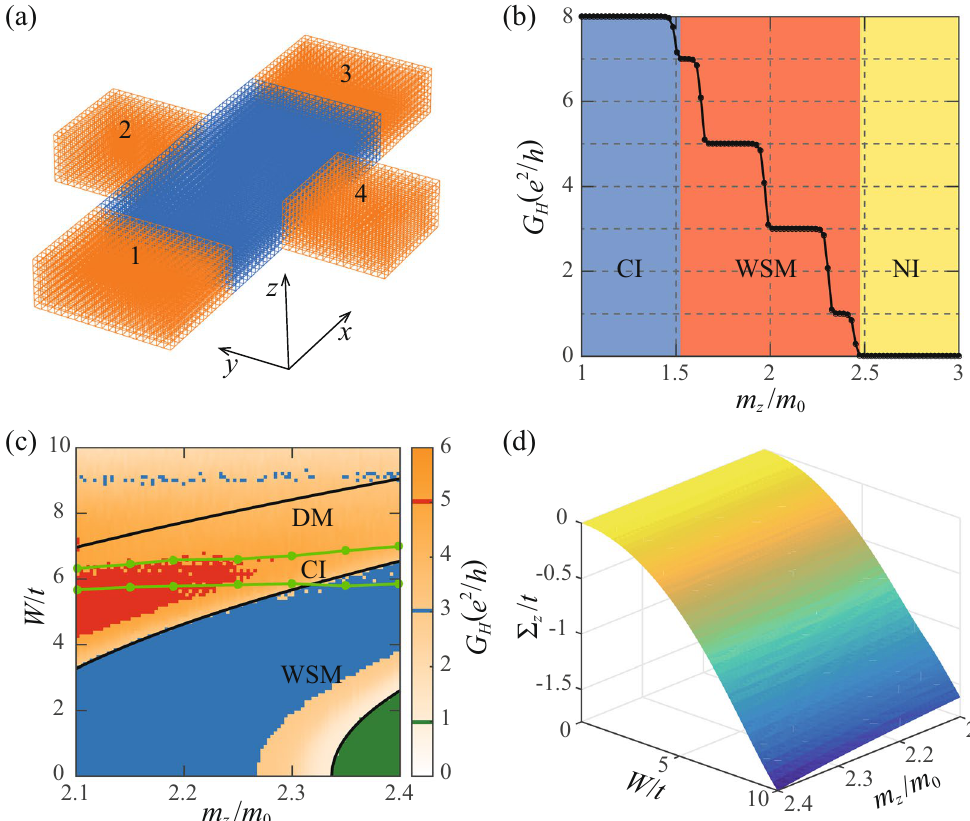
Figure 5. ( a ) The sketch of a four-terminal Hall bar. The blue region is described by the Hamiltonian Eq. (2). The four semi-infinite metallic leads are represented by the orange parts. ( b ) The Hall conductance as a function of m m / for the clean system. The shallow blue, red, and yellow regions mark the CI, WSM, and normal z 0 insulator (NI) phases, respectively. ( c ) The density plot of Hall conductance in the m m / disordered system. The three black lines (from bottom to top) are plateau-plateau transition lines obtained from the SCBA for = n 1 , 2, 3 in Eq. (7). The two green lines enclose the CI phase region according to the localization length calculations. ( d ) The Σ component of the self-energy obtained from the SCBA as a function of m m / z and W t /